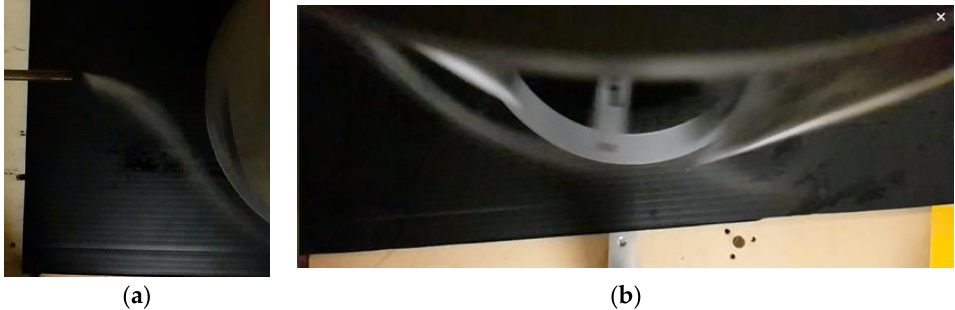
Figure 21. Velocity contour at 12 m/s wind speed and TSR of 0.1, with enlarged legend.